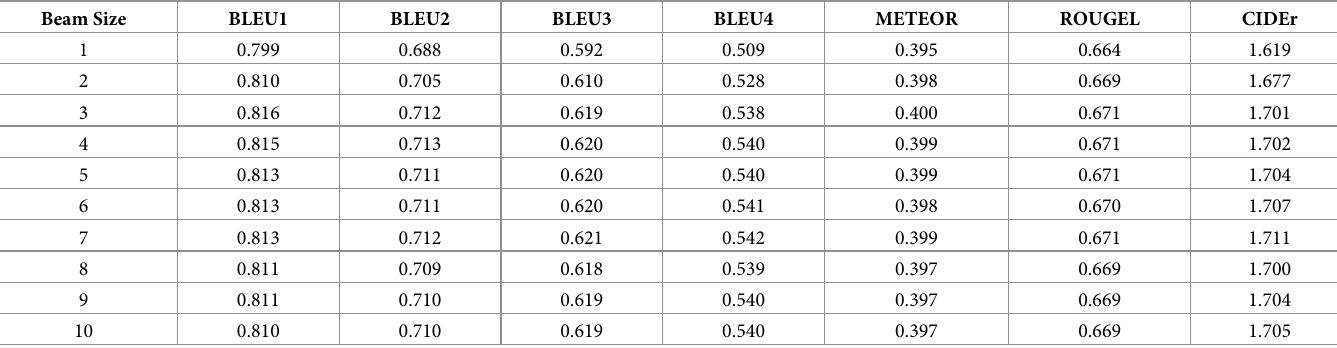
Table 3. Impact of different beam widths on model evaluation scores.